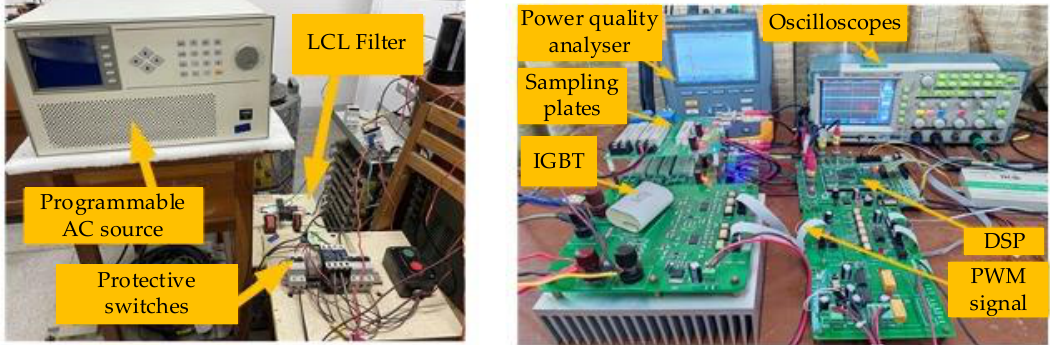
Figure 10. Experimental setup of the grid-connected converter.